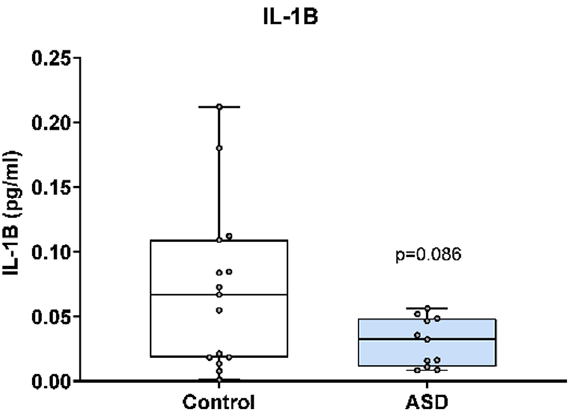
Figure 3. IL-1β concentration is ASD cases versus matched controls.